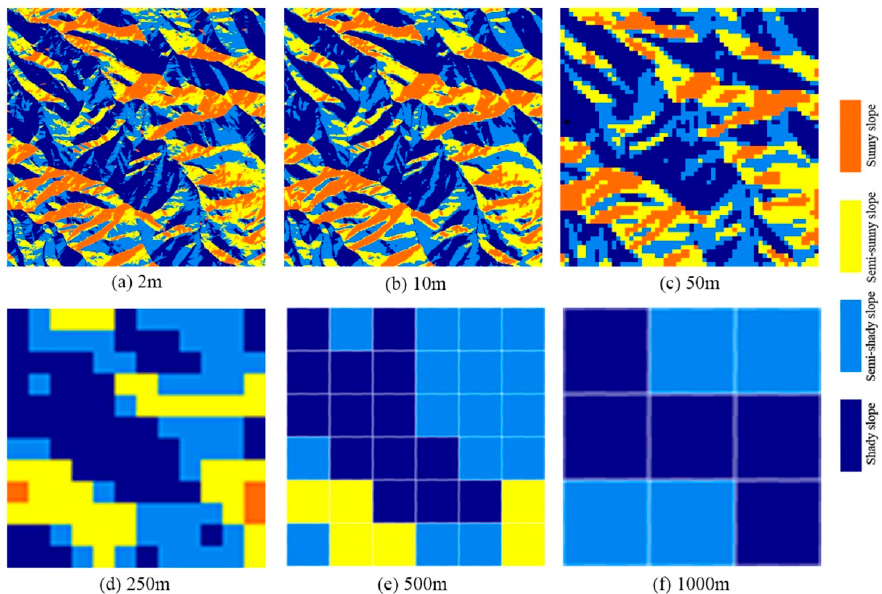
Figure 15. Aspect of Dayekou at different scales: ( a ) 2 m; ( b ) 10 m; ( c ) 50 m;( d ) 250 m; ( e ) 500 m; ( f ) 1000 m.